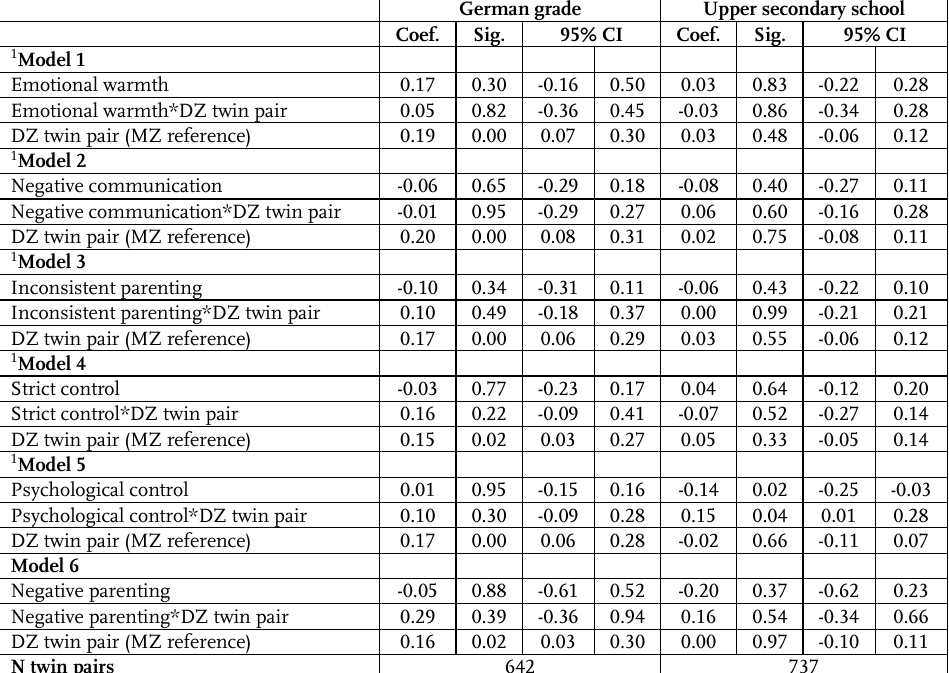
Table 8 : Regression output for the different models explaining trait differences in MZ and DZ twin pairs for twin pairs (continued) German grade Upper secondary school Coef. Sig. 95% CI Coef. Sig.